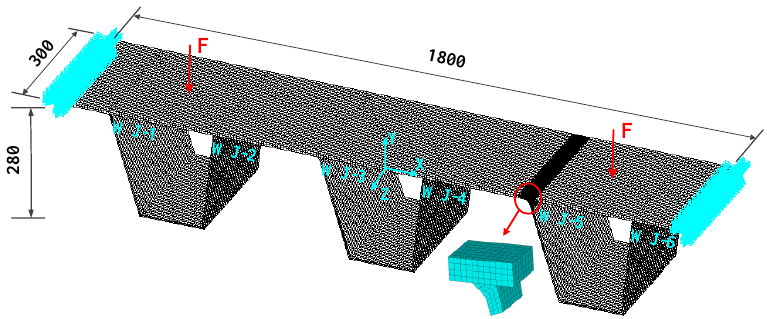
Figure 4. The multi-scale finite element model (FEM) of the deck-rib component (units: mm).